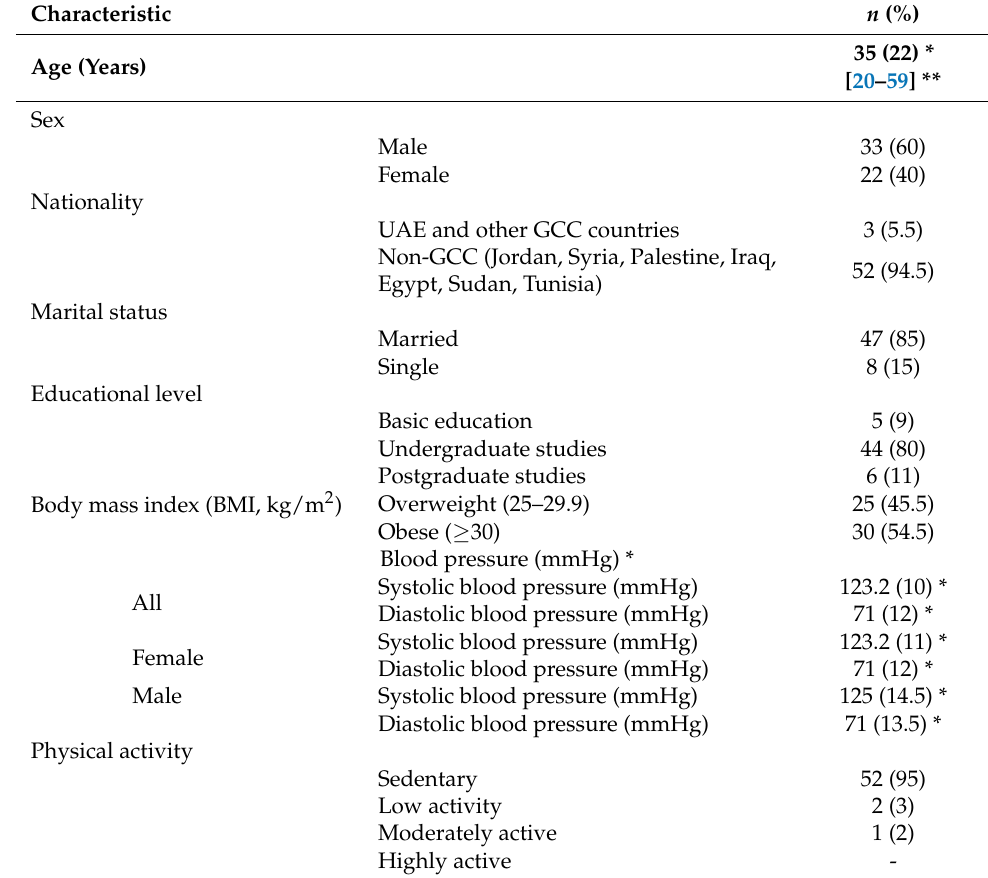
Table 1. Participants’ sociodemographic characteristics ( n =